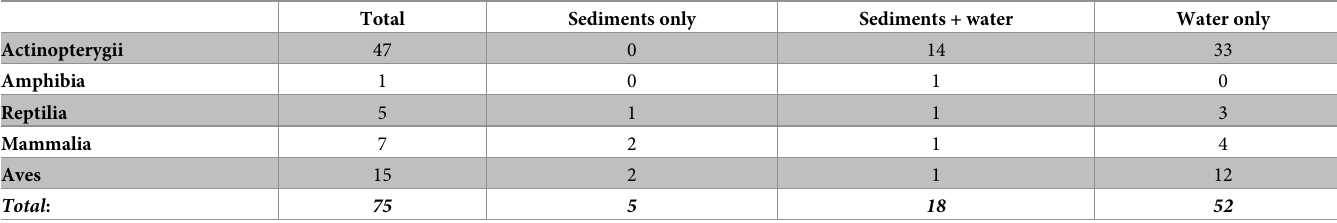
sediments (Table 3, Fig 3), five species were only recovered from sediments–racoon ( Procyon lotor ), pig ( Sus scrofa ), meso-american slider turtle ( Trachemys venusta ), brown jay ( Psilorhi- nus morio ), and great blue heron ( Ardea herodias ). However, all fish species detected in sedi- ment samples were also recovered from the water samples (Table 3, S1 Table). The three fish orders with highest number of detected species were Cichliformes (12 spe- cies), Cyprinodontiformes (11 species), and Gobiiformes (5 species) (S2 Table). Although Table 3. Number of species recovered from the sediment and water samples. Total Sediments only Sediments + water Water